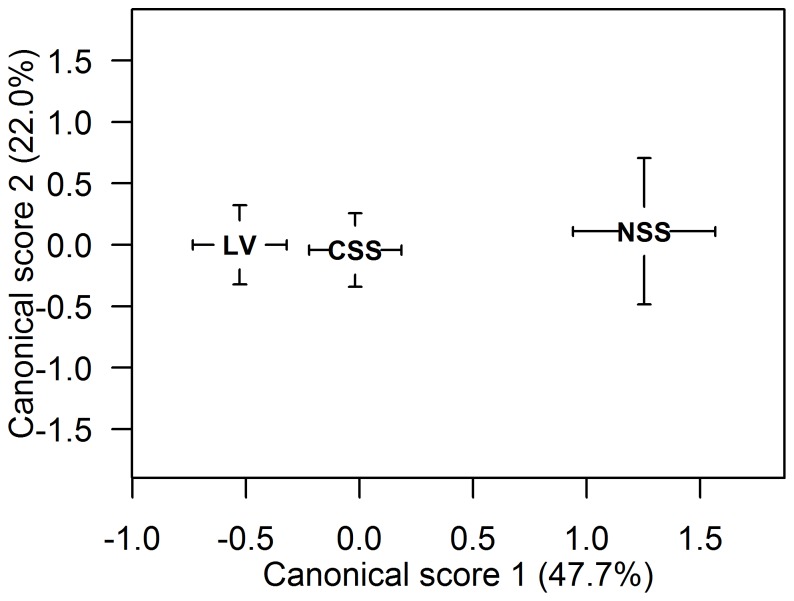
Otolith shape compared for different herring populations.Canonical scores for Norwegian spring spawning (NSS, N = 152), Coastal Skagerrak spring spawning (CSS, N = 397) and Landvik (LV, N = 348) herring are shown on discriminating axes 1 and 2. Black letters represent the mean canonical value for each group with standard error of the mean (1 SE).